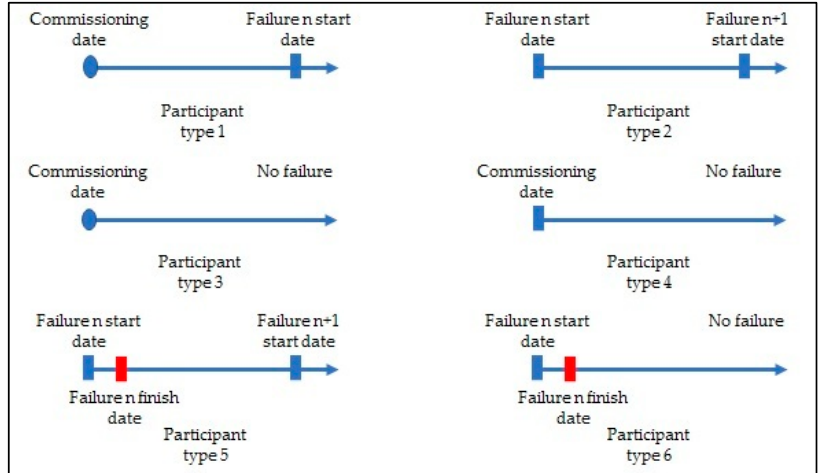
Figure 1. Types of participants considered in this study for the survival analysis.